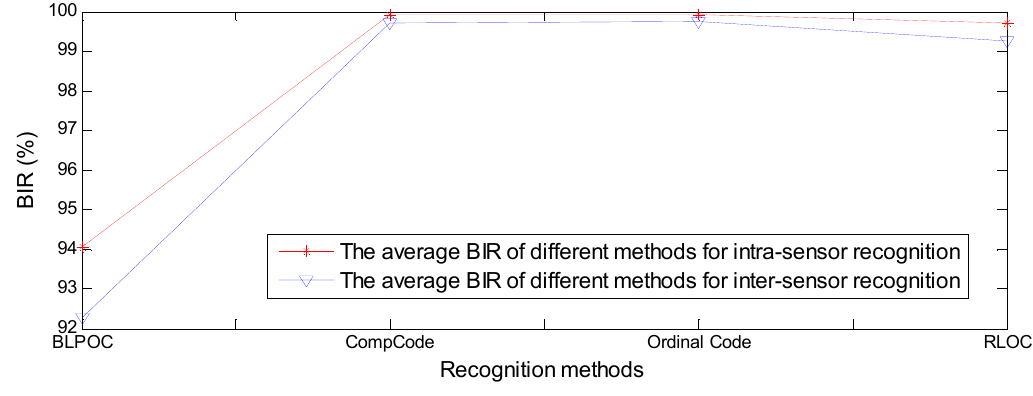
Figure 18. The average EER comparisons of BLPOC method and three orientation coding based methods between intra-sensor recognition and inter-sensor